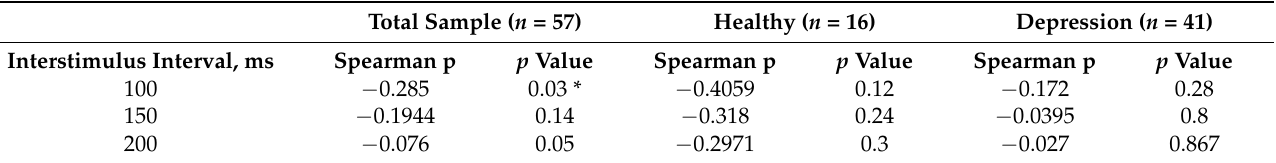
Table 3. Association between the cortical silent period and long-interval intracortical inhibition in adolescents.